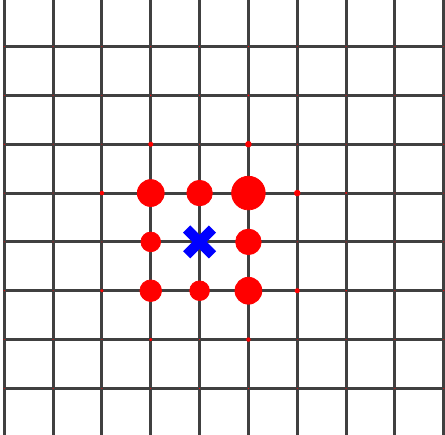
n h . i of j Ψ − i 2 h i j